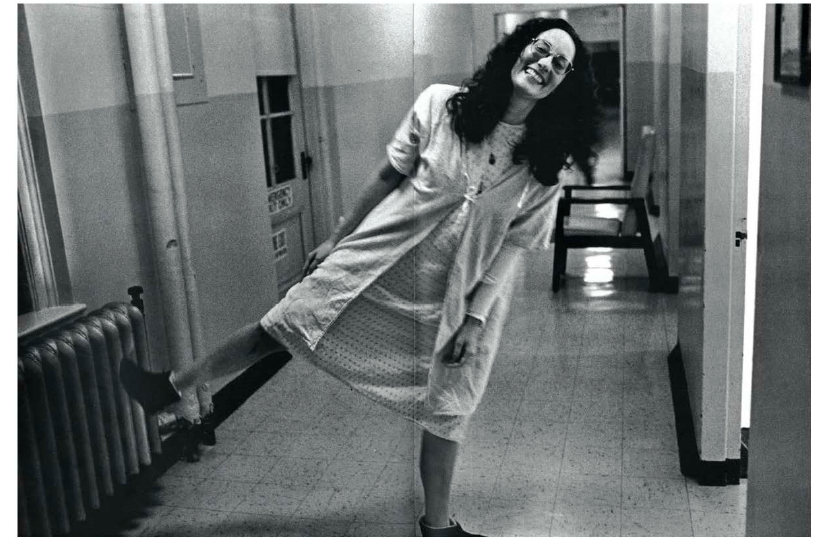
Figure 1. Courtesy Eugene Richards, Exploding into Life.